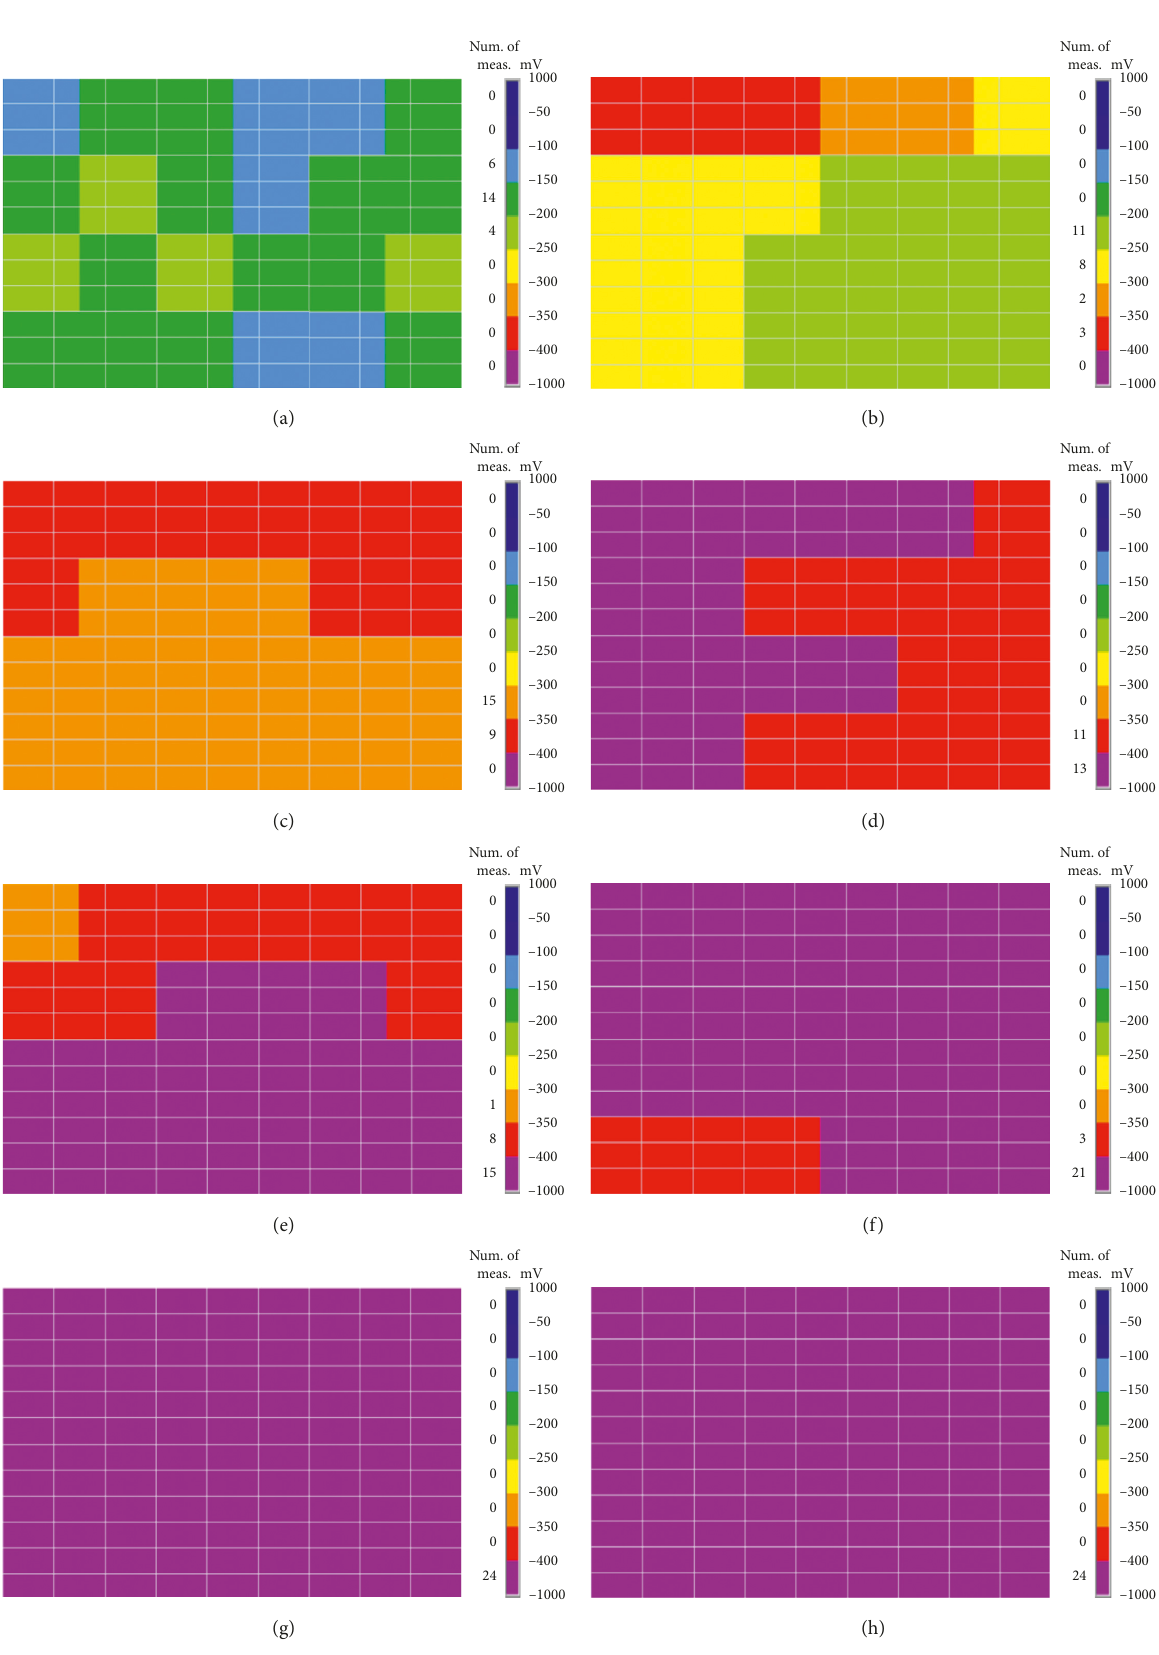
Figure 9: Potential map of beams controlled by shear: (a) SB-C0, (b) SB-C1, (c) SB-C2, (d) SB-C3, (e) SB-C4, (f) SB-C5, (g) SB-C6, and (h)